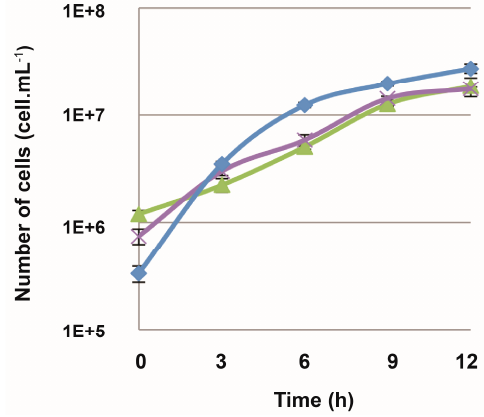
Figure 6. Growth curves of T. barophilus ∆ TERMP_00517 , T. barophilus ∆ TERMP_00517, ∆ TERMP_01623 ( polB ) and T. barophilus ∆ TERMP_00517 , ∆ TERMP_00671 ( rnhB ). The strains were cultivated at 85 °C and 0.1 MPa in TRM medium containing different concentration of 6-MP: T. barophilus ∆ TERMP_00517 , ∆ rnhB ( × ), T. barophilus ∆ TERMP_00517 , ∆ polB ( ▲ ) and T. barophilus ∆ TERMP_00517 (parental strain) ( ).